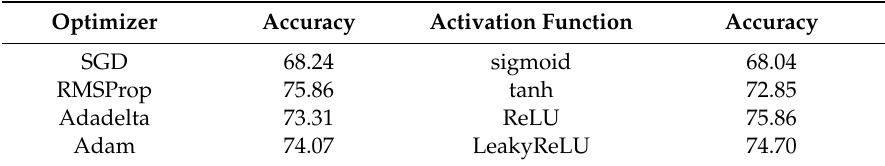
Table A2. Comparison with optimizer and activation